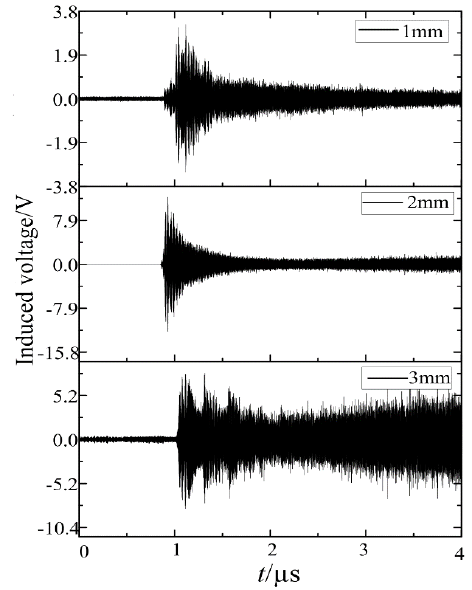
Figure 19. Induced voltage of the 3.3 V power line.